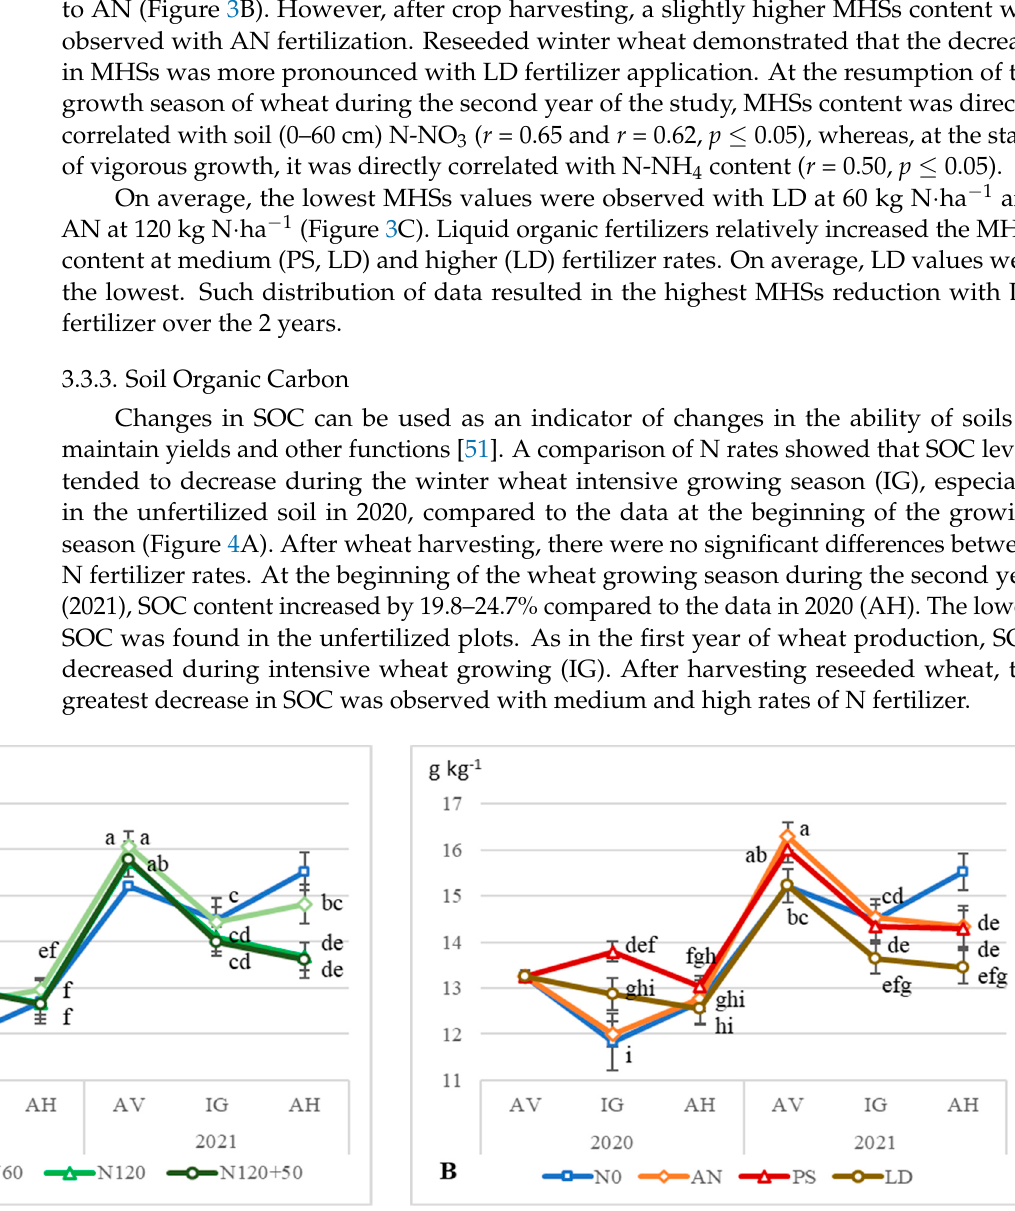
Figure 4. Variation of soil organic carbon (SOC) (0–30 cm) during winter wheat growing season as influenced by different nitrogen rates ( A ) and fertilizers ( B ). The standard error ( SE ) of the mean is used to represent error bars. Means with different letters within individual interactions are significantly different at the p < 0.05 level (N0 and AV2020 values were not included in the calculations; the letters are only implied). Abbreviations. Soil collection time: AV, at the beginning of winter wheat vegetation; IG, during intensive winter wheat growing (~1.5 months after AV and fertilization); AH, after winter wheat harvest. Nitrogen (N) rates: N0, unfertilized; N60, 60 kg N·ha − 1 rate; N120, 120 kg N·ha − 1 rate; N120+50, 120 + 50 kg N·ha − 1 rate. Fertilizers: N0, unfertilized; AN, ammonium nitrate; PS, pig slurry; LD, liquid anaerobic digestate.